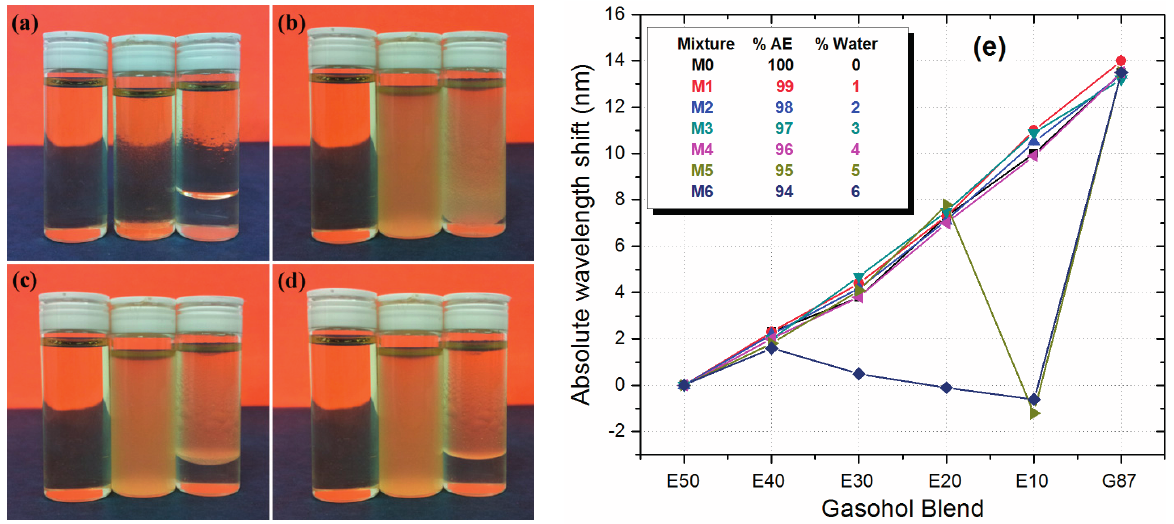
Figure 6. E10 gasohol samples with different water percentage of 1%, 5%, and 10% (left to right) with ( a ) After adding AE/water to G87; ( b ) After shaking the samples; ( c ) Three seconds after shaking; ( d ) Six seconds after shaking; and ( e ) Absolute peak wavelength response of the MMI sensor as function of gasohol blends with different water